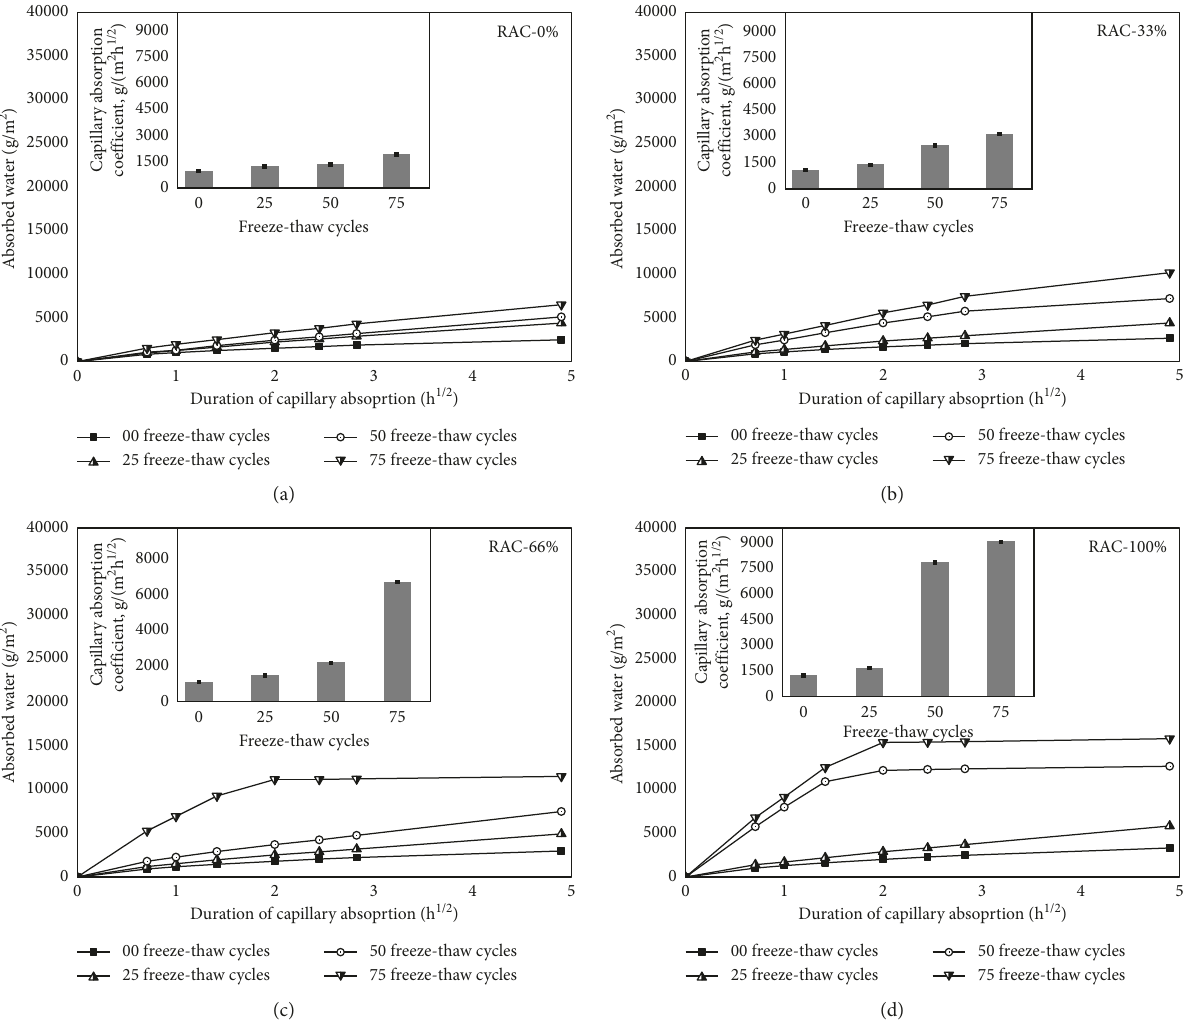
Figure 7: Capillary absorption curves of RAC after different freeze-thaw cycles. (a) RAC-0%, (b) RAC-33%, (c) RAC-66%, and (d) RAC-100%.